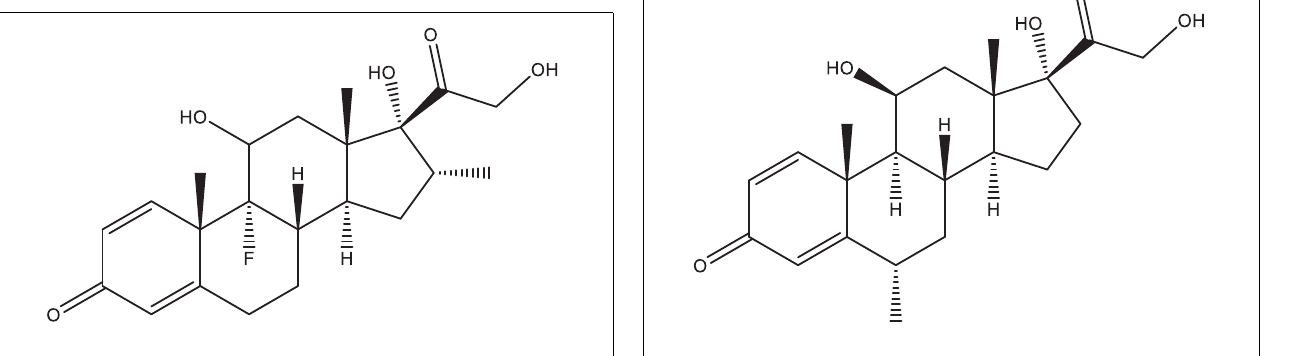
FIGURE 2 | Structure of 11 β ,17,21-trihydroxy-6 α -methylpregna-1,4-diene-3, 20-dione (methylprednisolone). This figure is made using